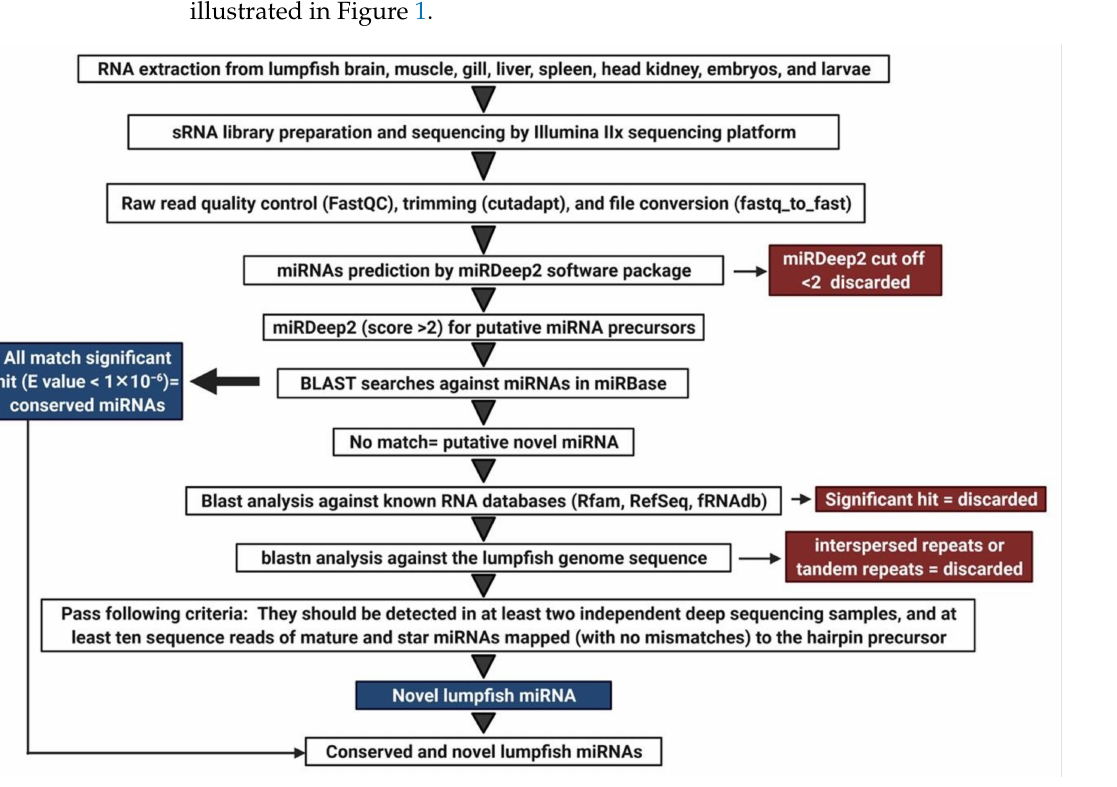
Figure 1. Experimental workflow used for characterization of lumpfish miRNAome. High-quality trimmed reads were used to discover lumpfish miRNA using the miRD- eep2 software package v0.0.7 (mapper and miRDeep2 analysis modules) applying